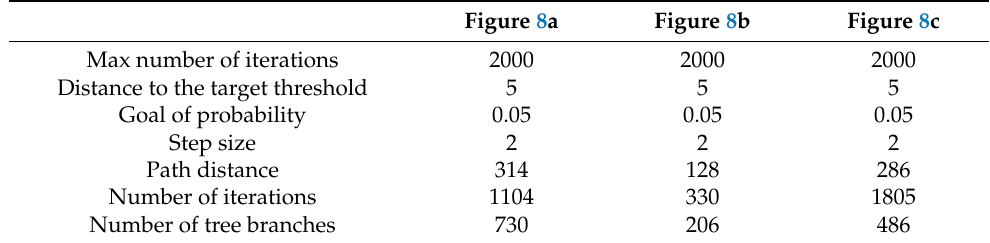
Figure 8. Results for the three path planning algorithms: ( a ) RRT* algorithm; ( b ) S-RRT* algorithm; ( c ) D-RRT* algorithm. Table 1. Information relating to Figure 8.